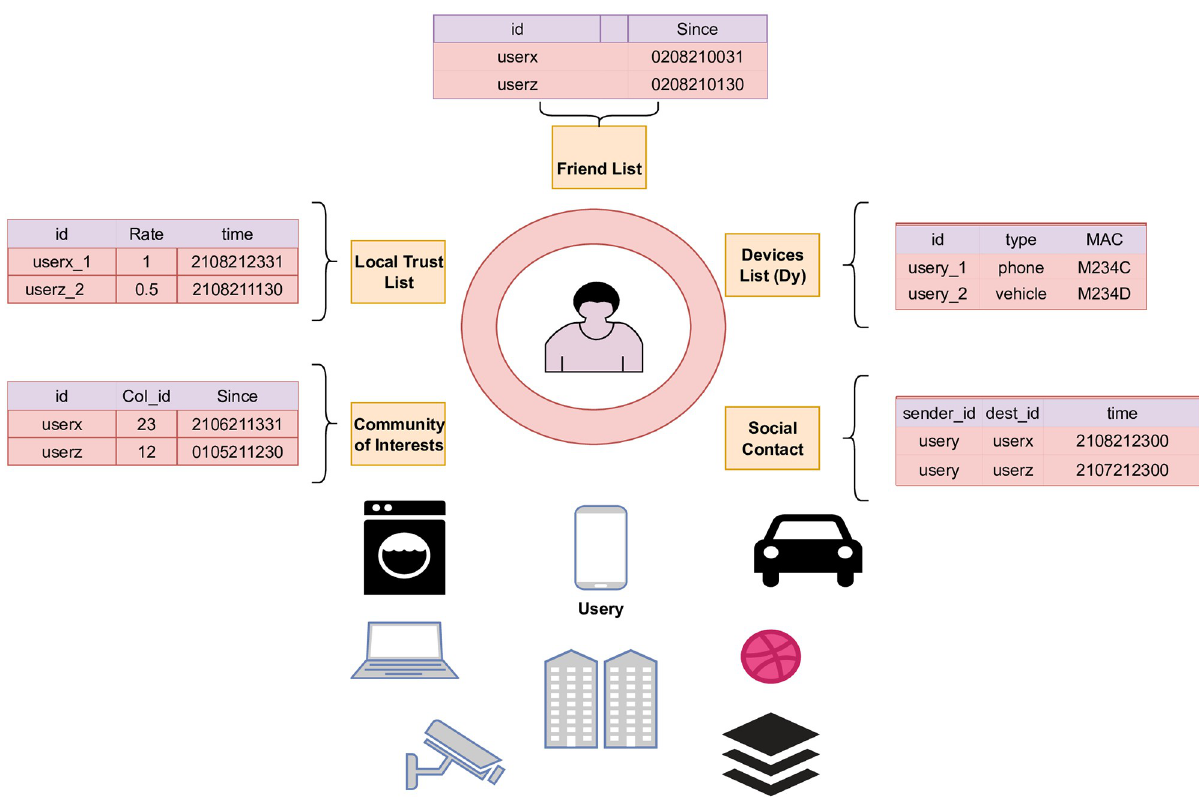
Fig 3. Local trust computing